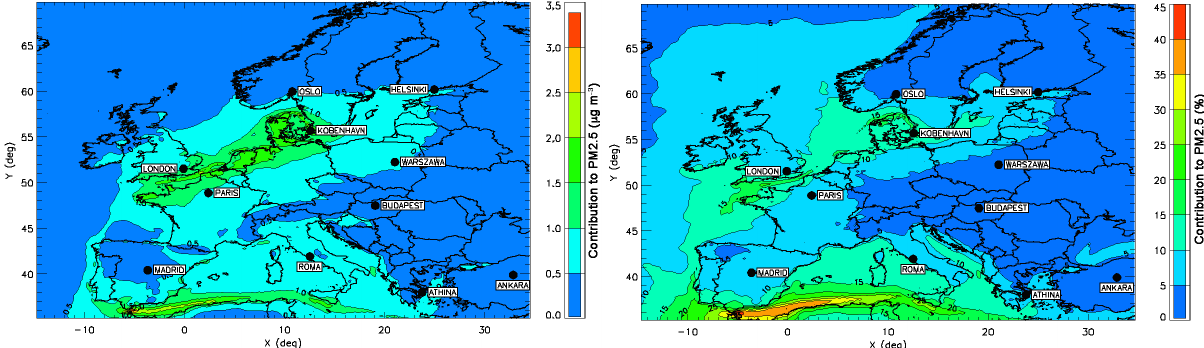
Figure 2. Contribution of ship emissions to the mean PM 2 . 5 concentration in 2006: left in µgm − 3 (base case − no ship), right in % ((base case − no ship) × 100/(base case)).